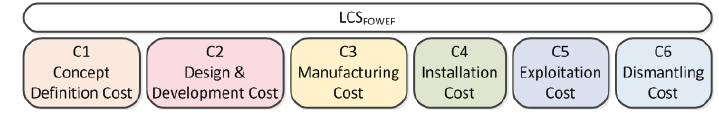
Figure 2. Sub-costs of the method proposed.